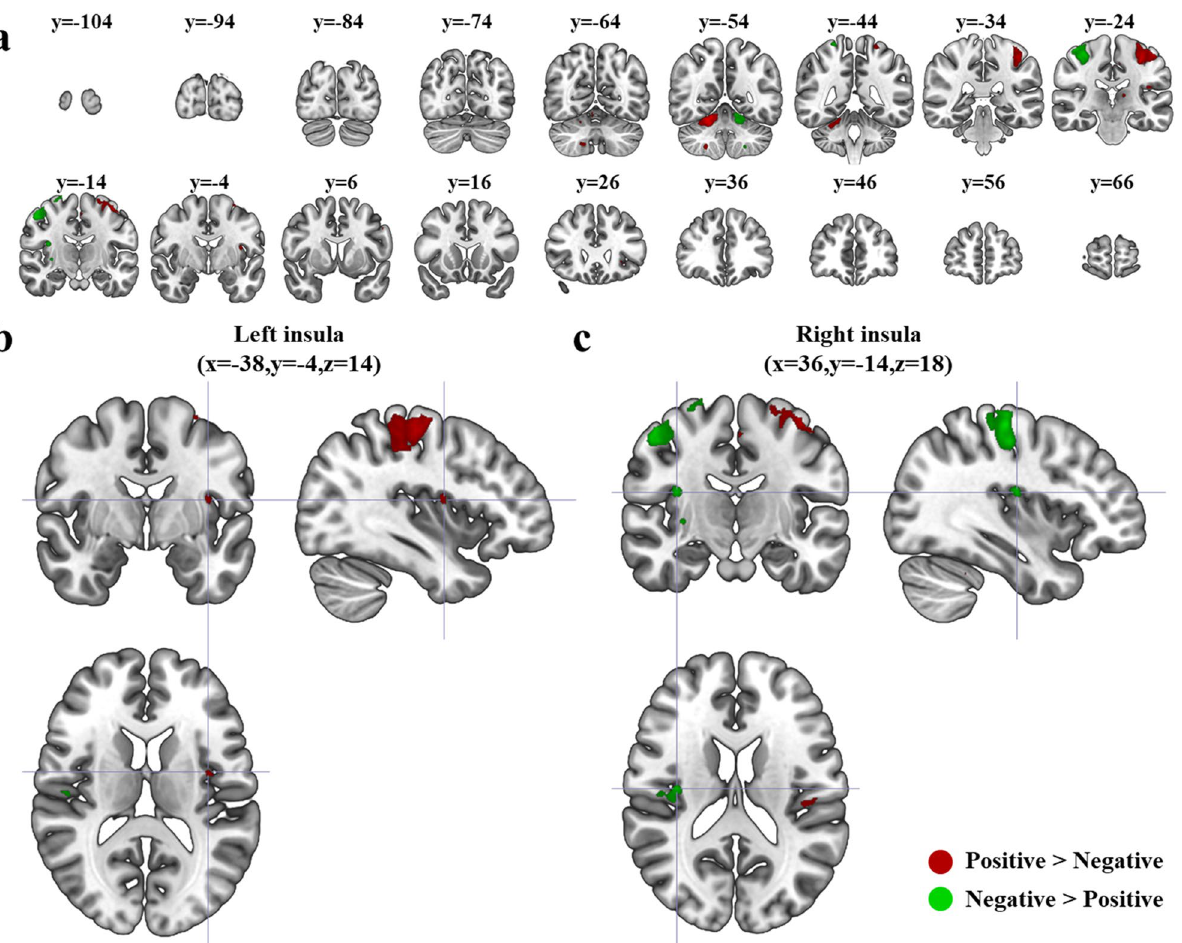
Figure 5. Brain regions revealing significant activations with the positive or negative evaluation of brand extension. ( a ) Twenty slices of the coronal view showing significant activations in either Positive > Negative or Negative > Positive contrast (FWE corrected, p < 0.05, cluster size > 10). Bilateral activations are observed in cerebellum, precentral gyri, postcentral gyri, insula, and putamen; ( b ) Left insula shows significant activation in Positive > Negative contrast (FWE corrected, p < 0.05, cluster size > 10) and ( c ) Right insula shows significant activation in Negative > Positive contrast (FWE corrected, p < 0.05, cluster size >